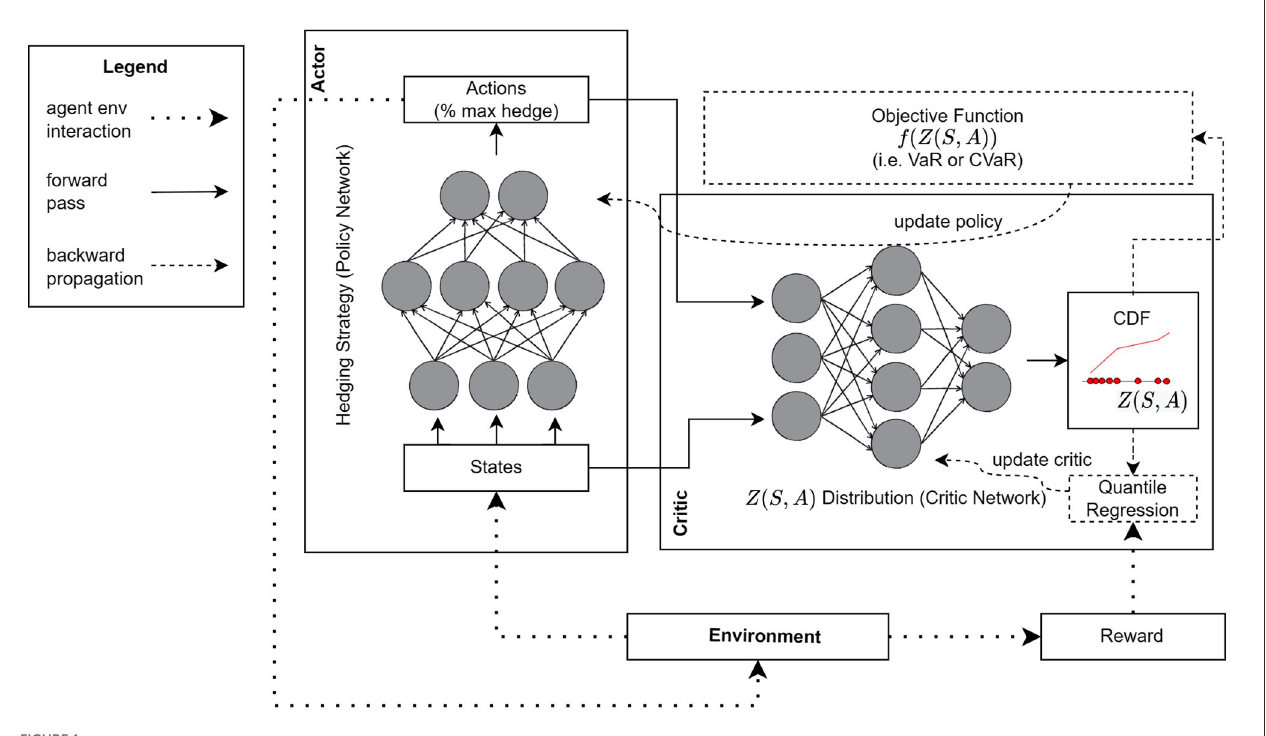
FIGURE1 RL architecture for actor-critic learning and proposed